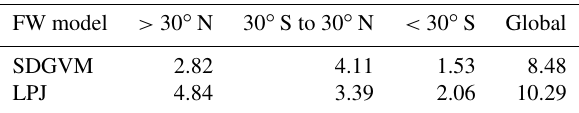
Table 4. Eocene monthly mean max3NN modelled FW